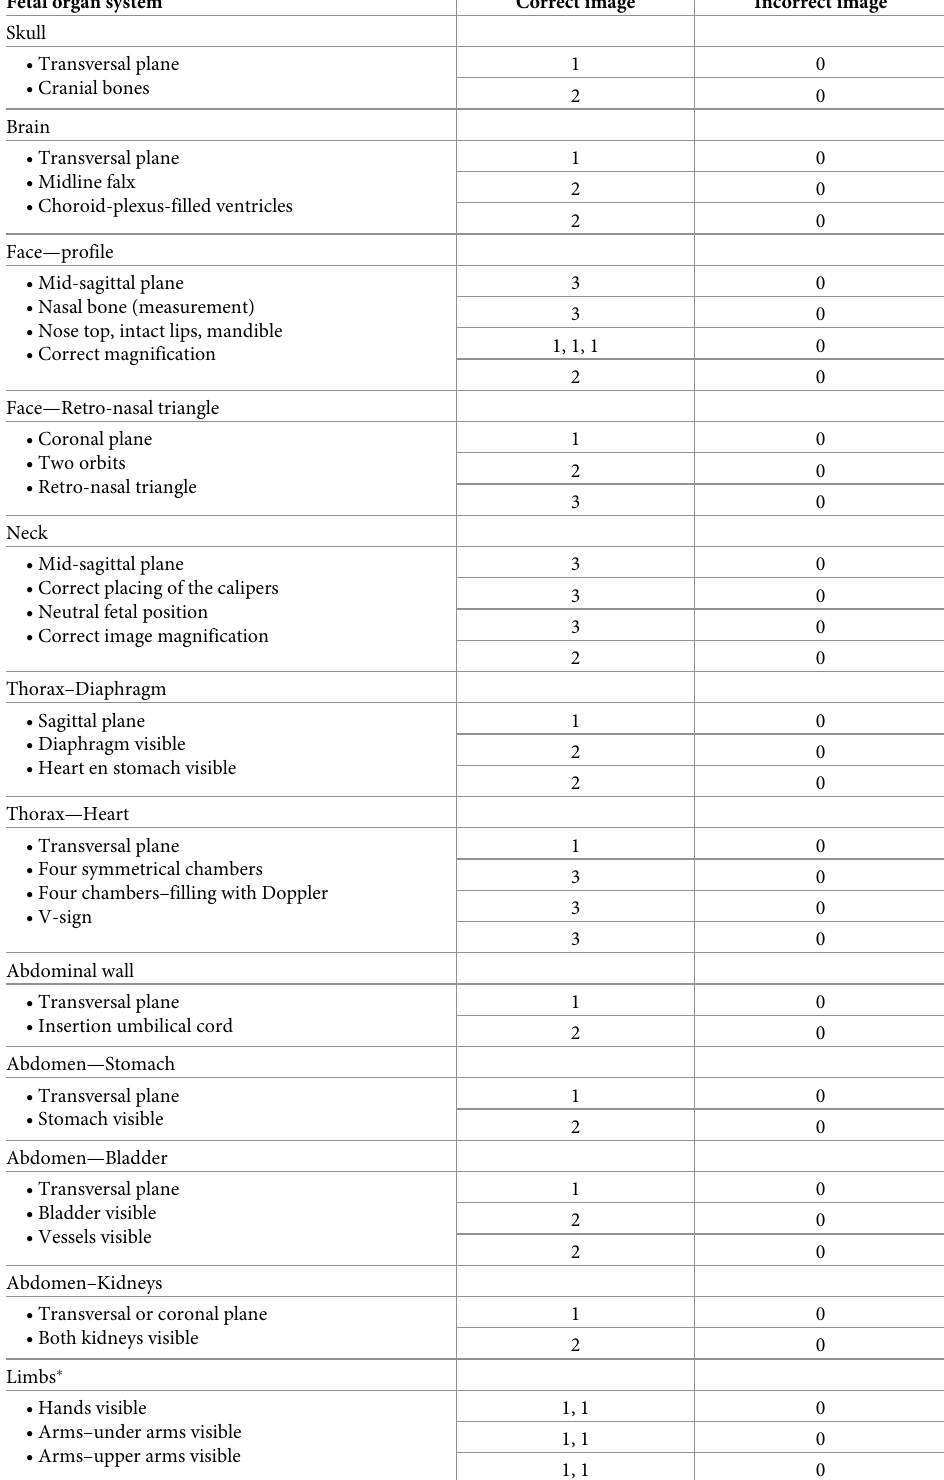
Table 1. Item scoring protocol per organ